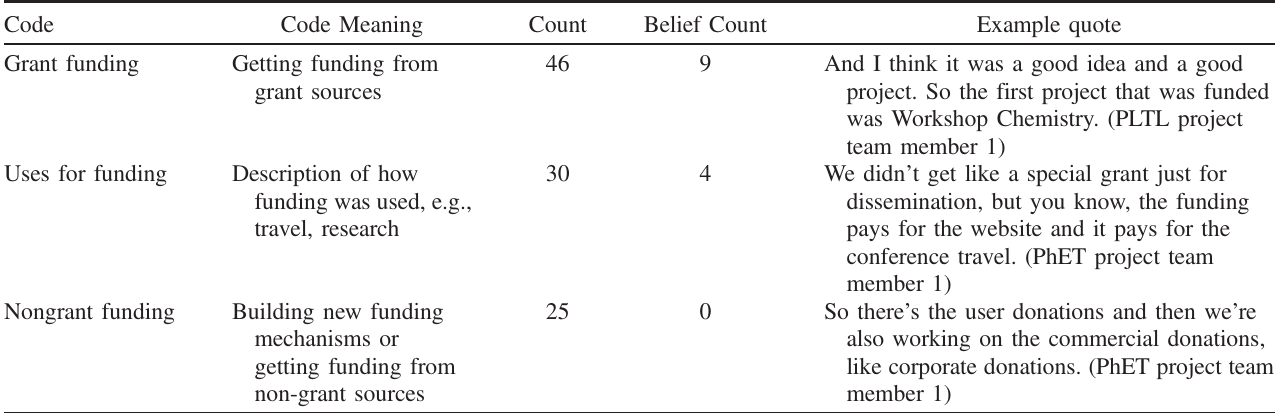
TABLE IX. Frequently used codes and example quotes for the funding category.